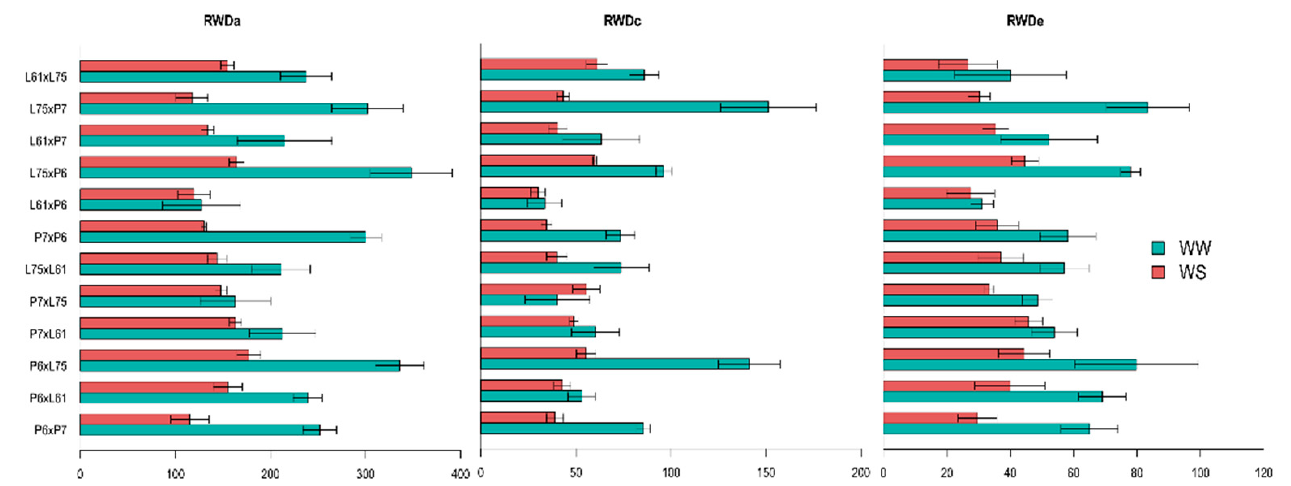
Figure 7. Estimates of means of root traits in popcorn hybrids evaluated under water stress (WS) and well-watered (WW) conditions. WS: water stress; WW: well-watered; RWD a : root weight den- sity of the section a (0–30 cm); RWD c : root weight density of the section c (60–90 cm); RWD e : root weight density of the section e (120–150 cm).